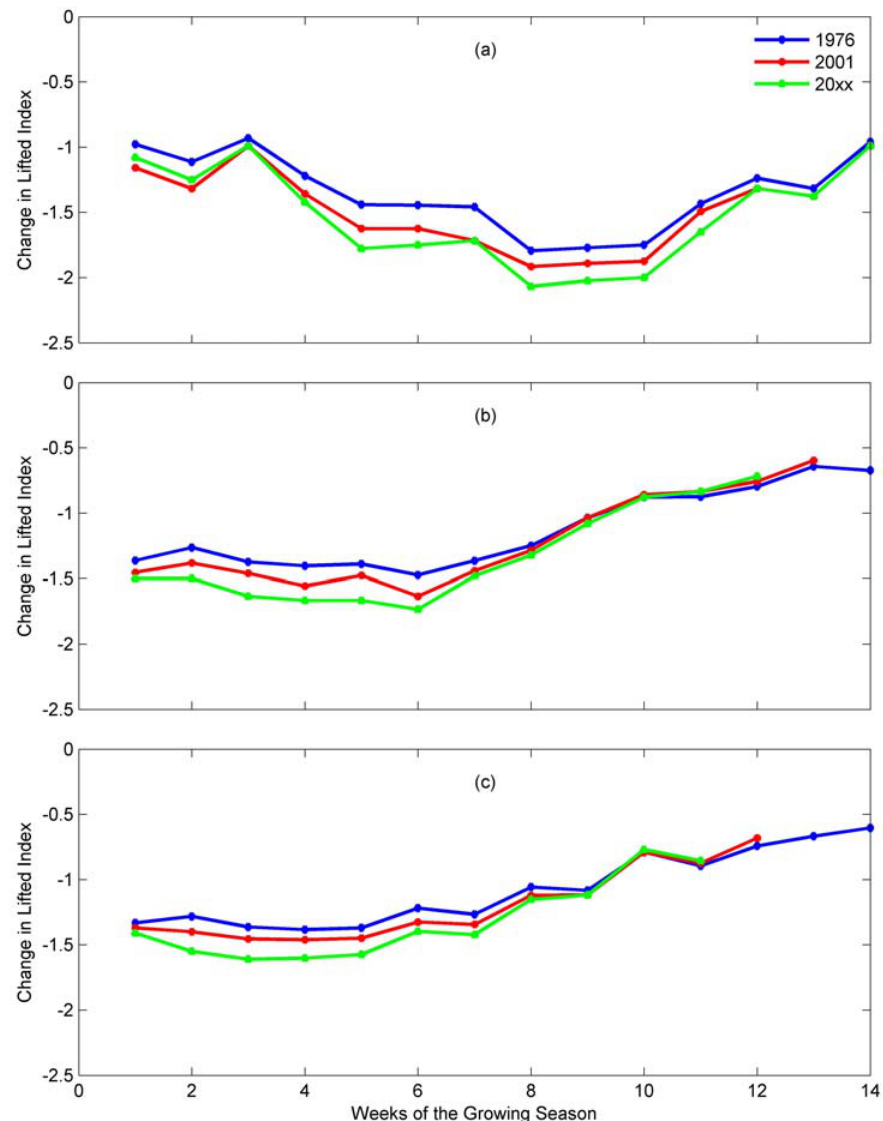
Figure 6. Mean change in lifted index for 1976, 2001 and 20xx during the growing season at representative weather stations for three soil zones; ( a ) Edmonton-Black soil zone, ( b ) Lethbridge-Dark Brown soil zone, and ( c ) Vauxhall -Brown soil zone. Week #1 is the last week of